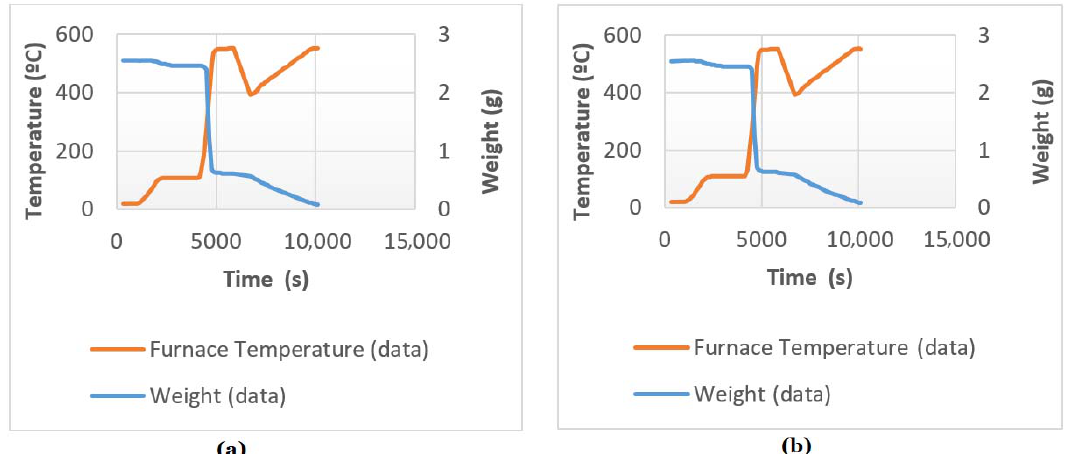
Figure 3. TGA weight ‐ loss curves for ( a ) debarked acacia and ( b ) acacia with bark.